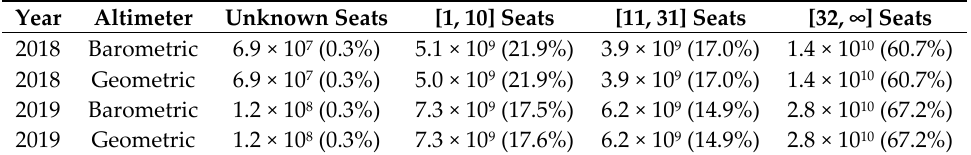
Table 1. Frequency of fixed wing multi-engine operating at or below 18,000 feet AGL.